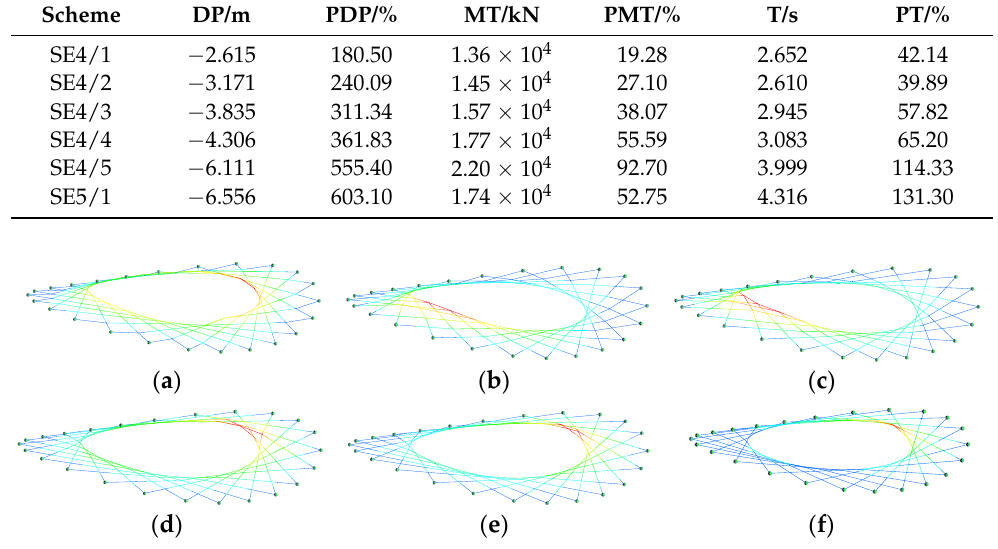
Figure 11. Vibration modes of schemes when deleting four or five virtual rings. ( a ) SE4/1; ( b ) SE4/2; ( c ) SE4/3; ( d ) SE4/4; ( e ) SE4/5; ( f )